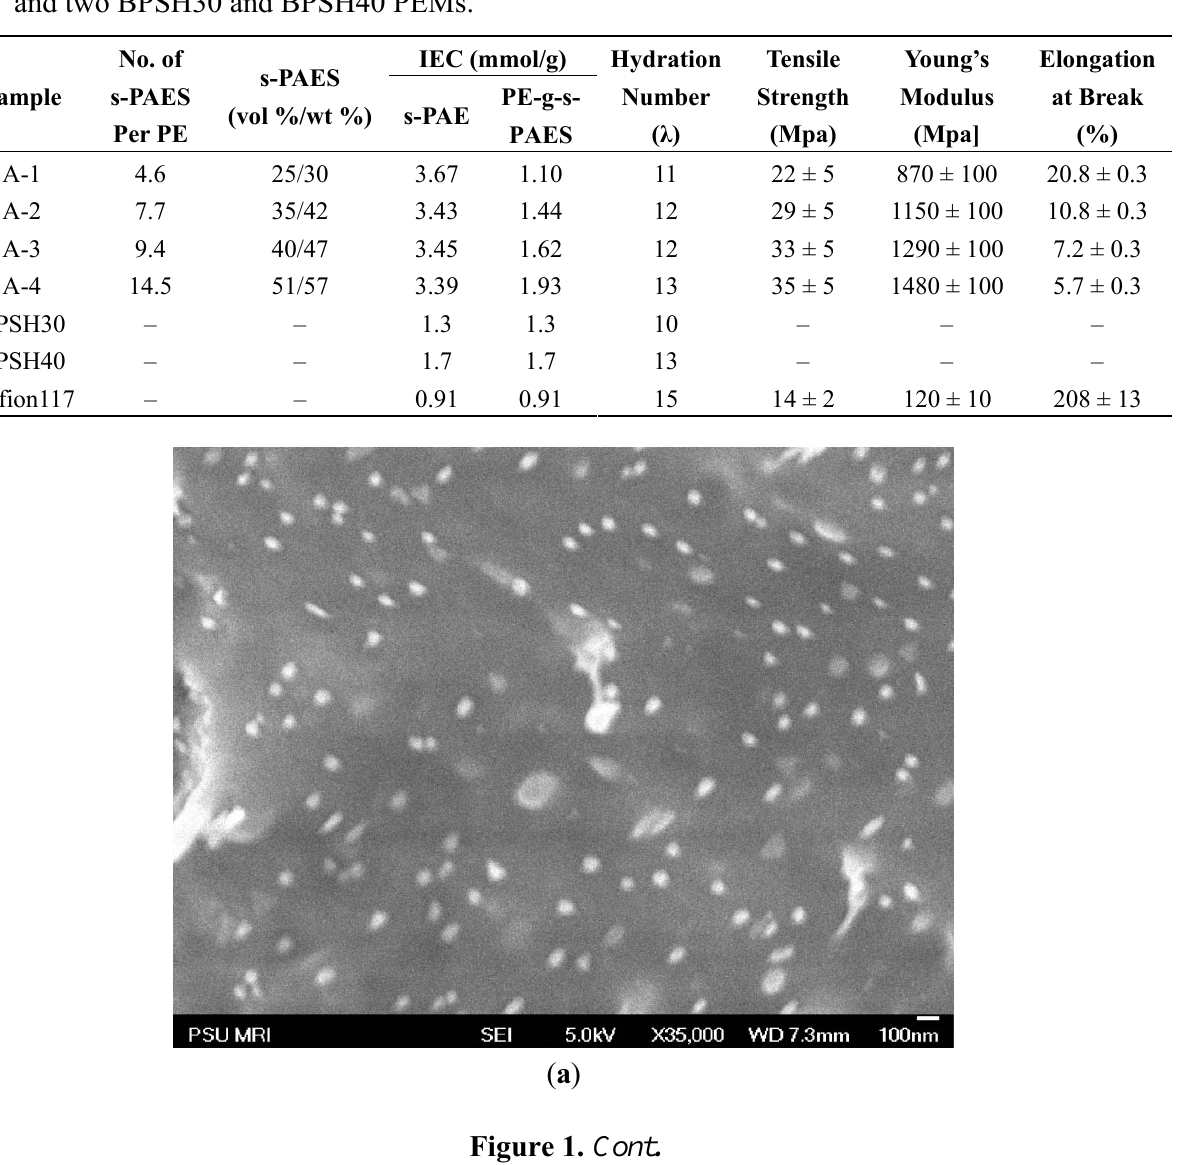
Table 1. Illustration and summary of molecular structure, ion exchange capacity, hydration number, mechanical properties of PE-g-s-PAES PEMs, and the comparison with Nafion 117, and two BPSH30 and BPSH40 PEMs.